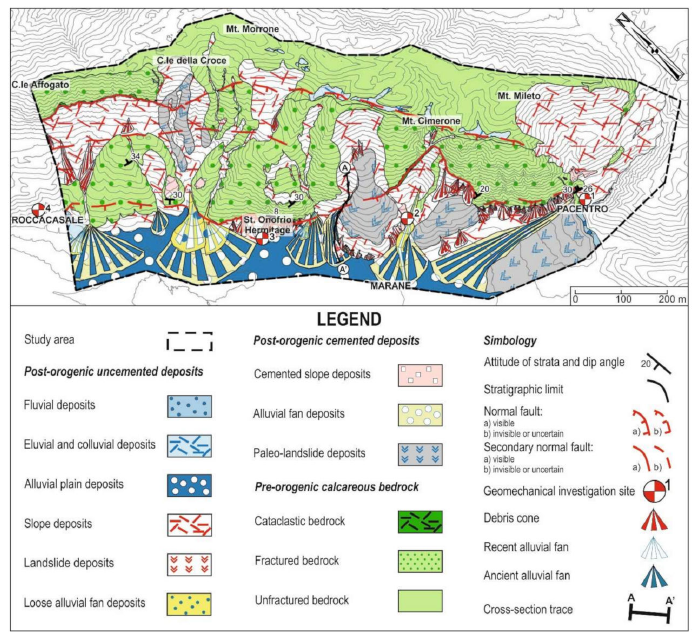
Figure 12. Geolithological map of the study area. The cross-section trace matches with the August 2018 debris flow